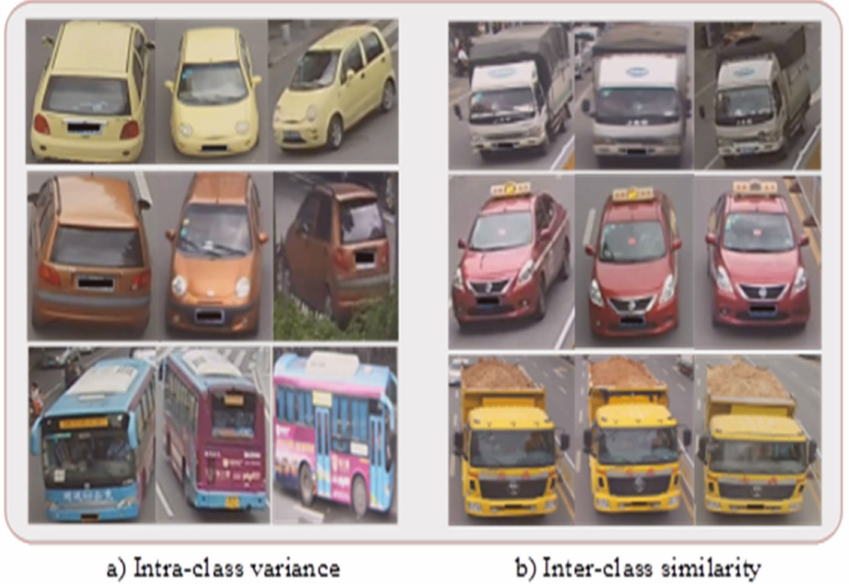
Figure 27. Demonstration of two main challenges in vehicle re-id. ( a ) Intra-class variance; ( b ) Inter-class similarity.